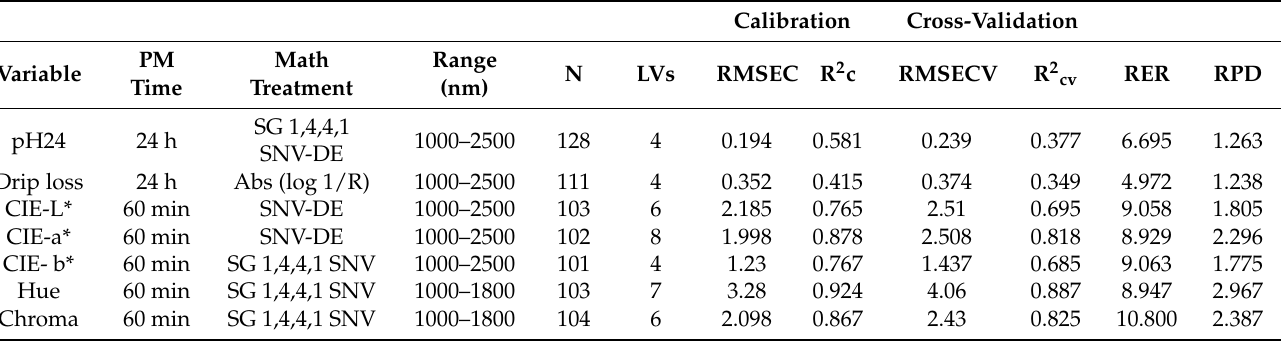
Table 4. Best-fitting NIR prediction equations (calibration and cross-validation statistics) for main quality traits of Longissimus thoracis muscle from Total sample set, including Asturiana de los Valles, Rubia Gallega, and Retinta